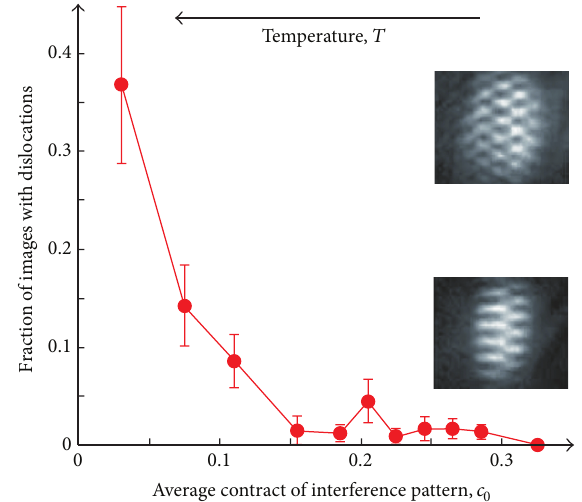
Figure 4: Fraction of the interference patterns showing at least one dislocation as a function of the interference contrast 𝑐 0 . Inset, examples of images with the increasing number of dislocations (from bottom to top). Adapted by permission from Macmillan Publishers Ltd: Nature , vol. 441, no. 7097, pp. 1118–1121, © 2006.